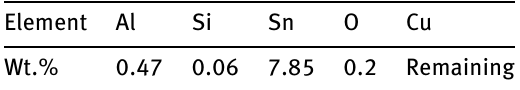
Table 1: Chemical composition of Cu-Sn alloy in weight percentage.